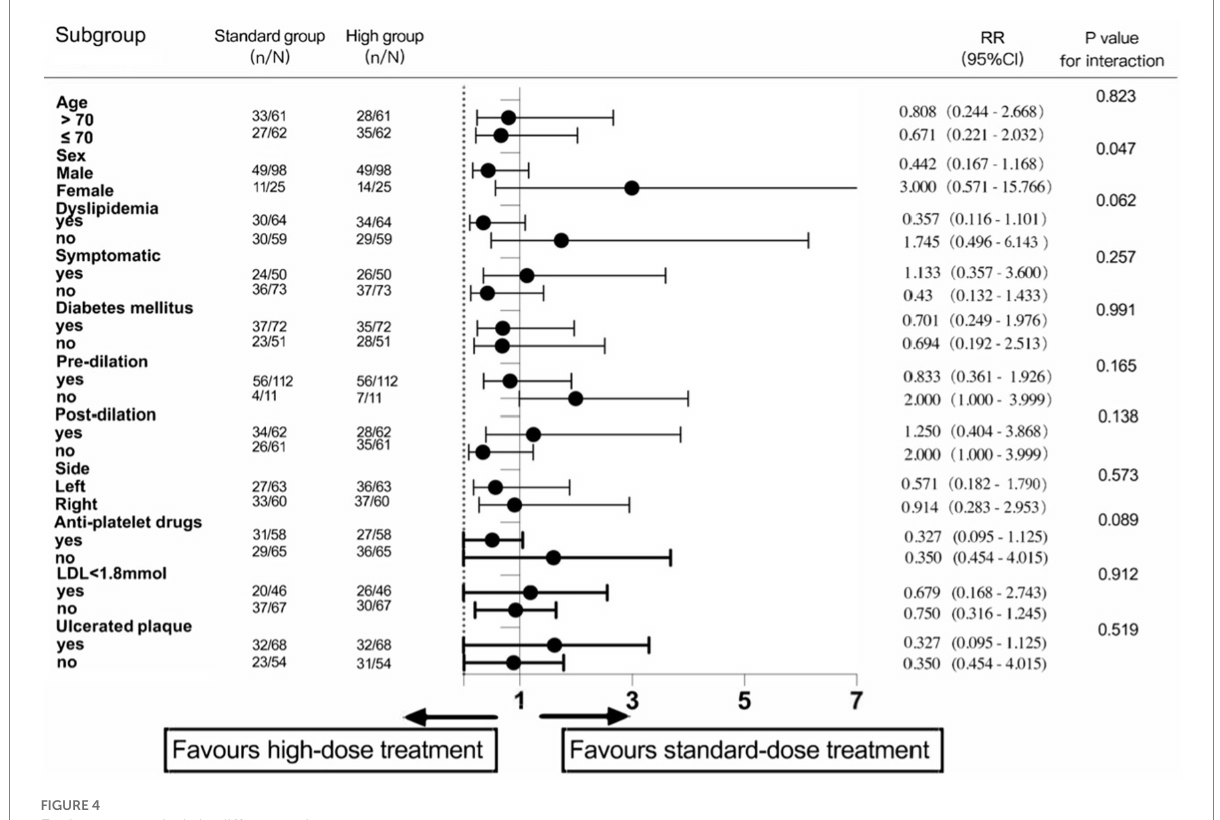
FIGURE 4 Exploratory analysis in different